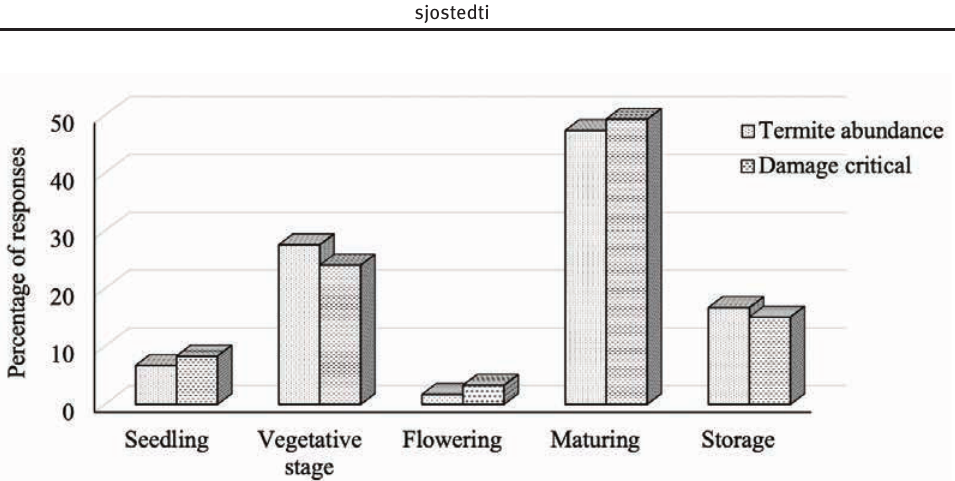
Figure 2: Famers perception of termite abundance and damage in relation to maize development stage as evaluated by surveyed farmers (N =